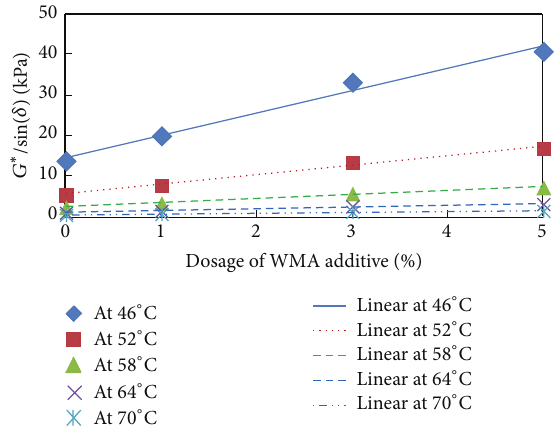
Figure 7: Rutting factors of 70# virgin asphalt and WMA binder. Figure 8: Rutting factors of 90# virgin asphalt and WMA